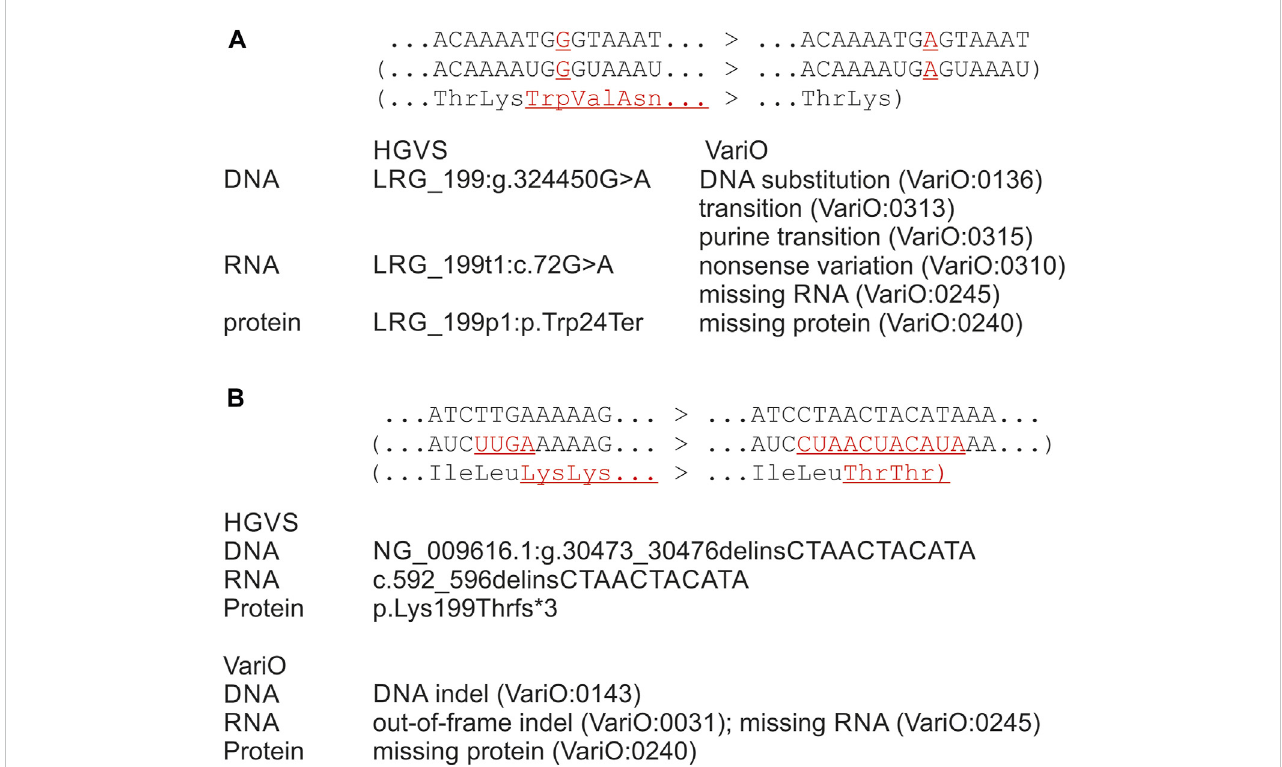
FIGURE 1 Examples for outcomes of premature stop codon-introducing variants, original sequence to the left and the variant to the right. Systematics both with HGVS and VariO annotations is for observed or predicted outcomes of variants. (A) Substitution in DMD gene introduces a PTC, therefore the transcript is degraded and no protein in produced. HGVS annotation indicates imaginary effects on RNA and protein levels. Therefore, variants like this are considered as protein truncations, although no protein is produced. VariO annotations of missing RNA and missing protein describe the actual changes. On RNA level, annotation for non-sense variation can be added to indicate what is the reason for missing RNA. (B) Indel in BTK gene introduces out-of-frame indel at RNA with PTC. No protein is produced due to NMD. The correct HGVS annotations in both examples is on RNA level either r.0 or r (0) and on protein level p.0 or p.(0). HGVS annotations were produced with VariantValidator, which follows the HGVS annotation rules. Differences in the original and variant strands are in red and underlined. RNA and protein changes are in brackets as they are theoretical constructions, in reality the molecules do not